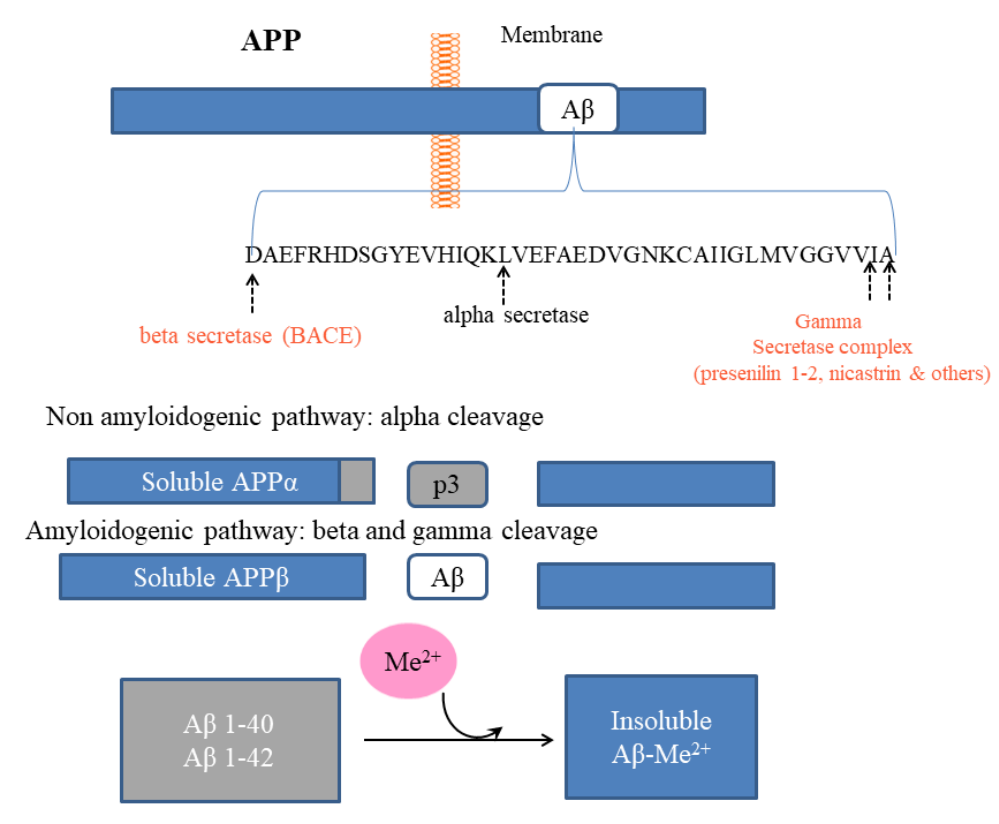
Figure 5. Pathway of A β production: the link with metals. The main constituent of amyloid aggregates is A β , a peptide of 39-43 amino acids, resulting from the cleavage of APP a transmembrane protein. More specifically, it has been reported that APP can be processed into two separate pathways. In the amyloidogenic pathway, APP is first cleaved by β -secretase at a site outside the cell surface. This generates a C-terminal fragment that is subsequently cleaved by γ -secretase at a site within the transmembrane domain. The product of this cleavage is A β . In the non-amyloidogenic pathway, APP is initially cut by α -secretase and then by γ -secretase, releasing a truncated P3 fragment. It was found that APP has specific copper and zinc-binding domains that catalyze redox activity, determining A β precipitation in plaques even at minimal concentrations. Copper and zinc domain in the A β peptide bind equimolar amounts of the two metals (Me 2+ ). However, under acidosis conditions, A β zinc is copper completely displaced by copper.